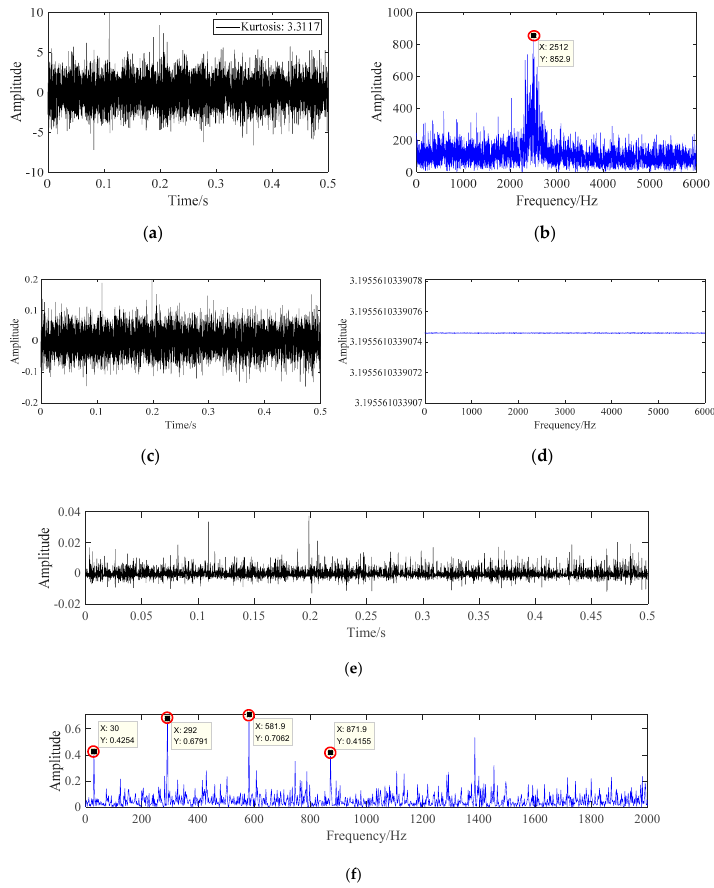
Figure 7. AR filtering signal diagram. ( a ) Time domain diagram of AR filtering signal. ( b ) Frequency domain diagram of AR filtering signal. ( c ) Time domain diagram of whitening signal. ( d ) Frequency